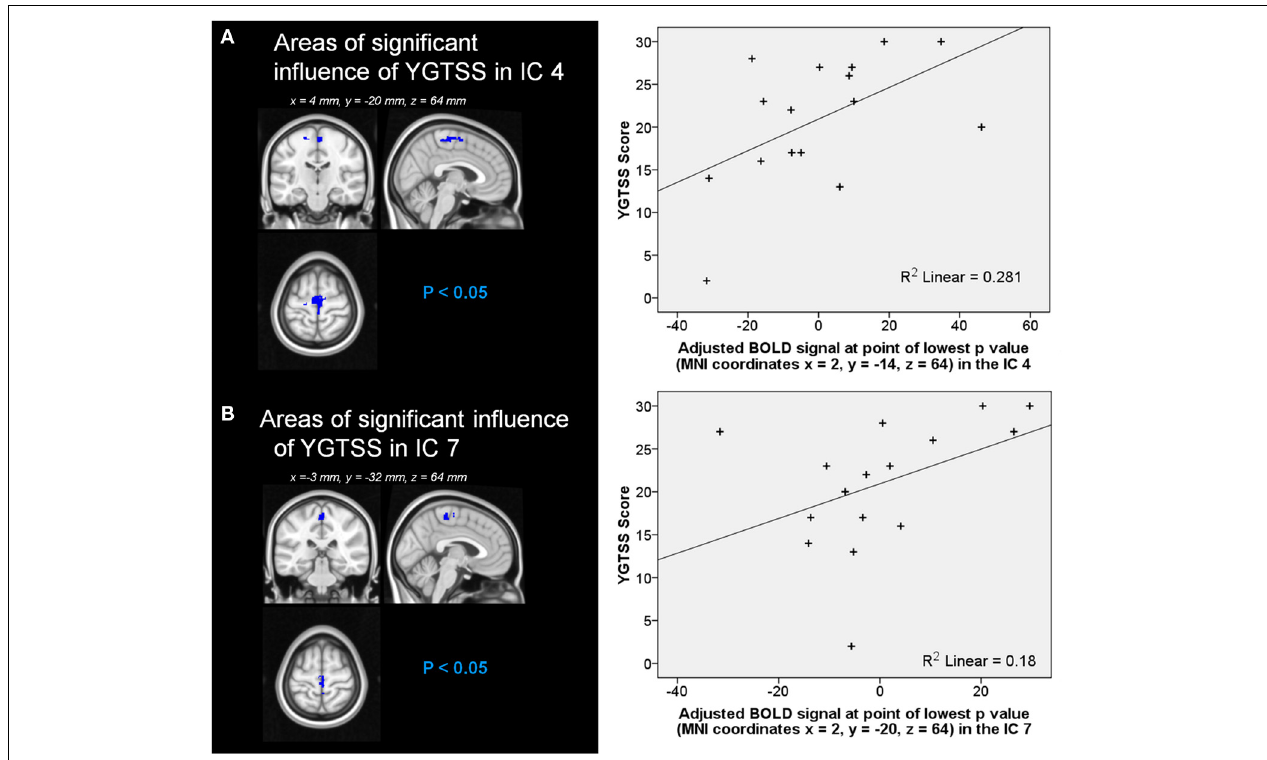
FIGURE 7 | Influence of YGTSS on network strength of RSNs (A) 4 and (B) 7. Graphical representation of the YFTSS in function of (A) the adjusted BOLD signal at point of lowest p-value (MNI coordinates x = 2,